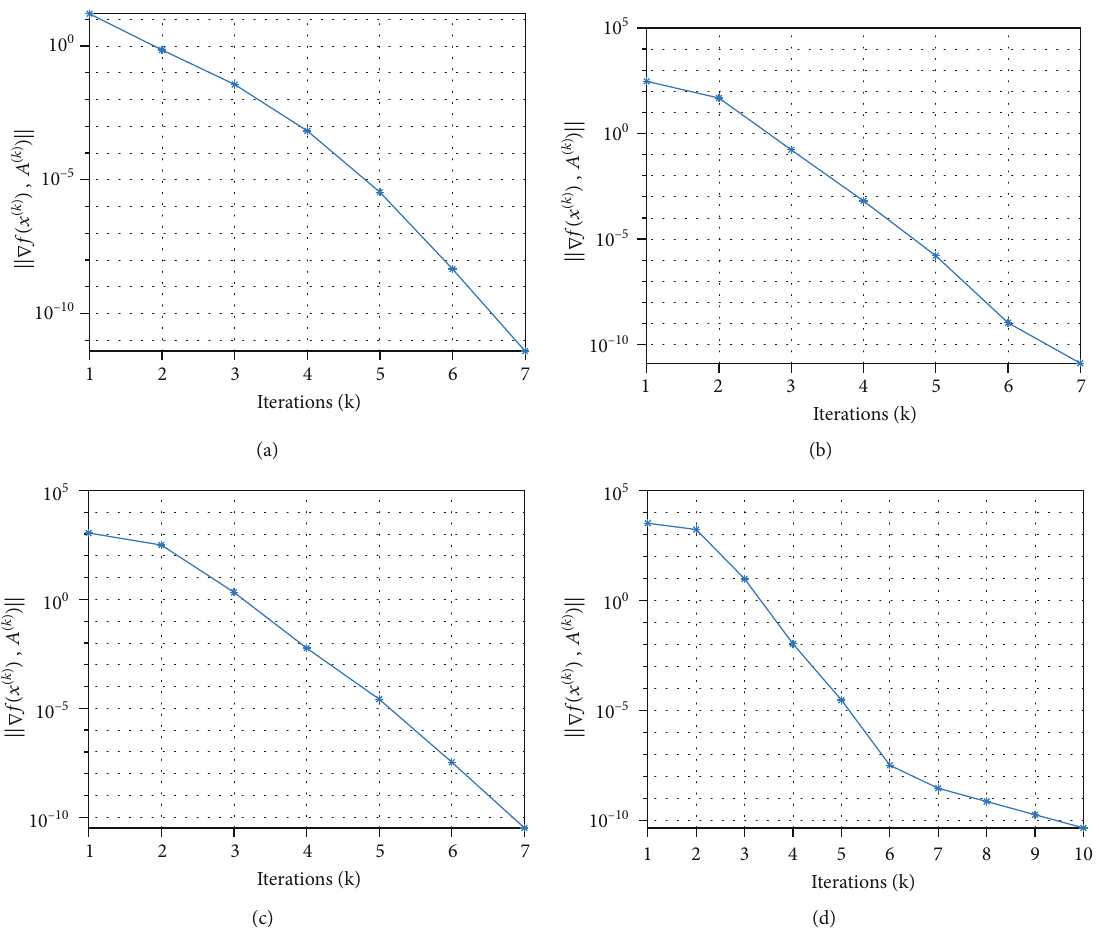
Figure 2: Diagrams of error k ∇ f ð x ð k Þ , A ð k Þ Þk versus iterations k of experiment